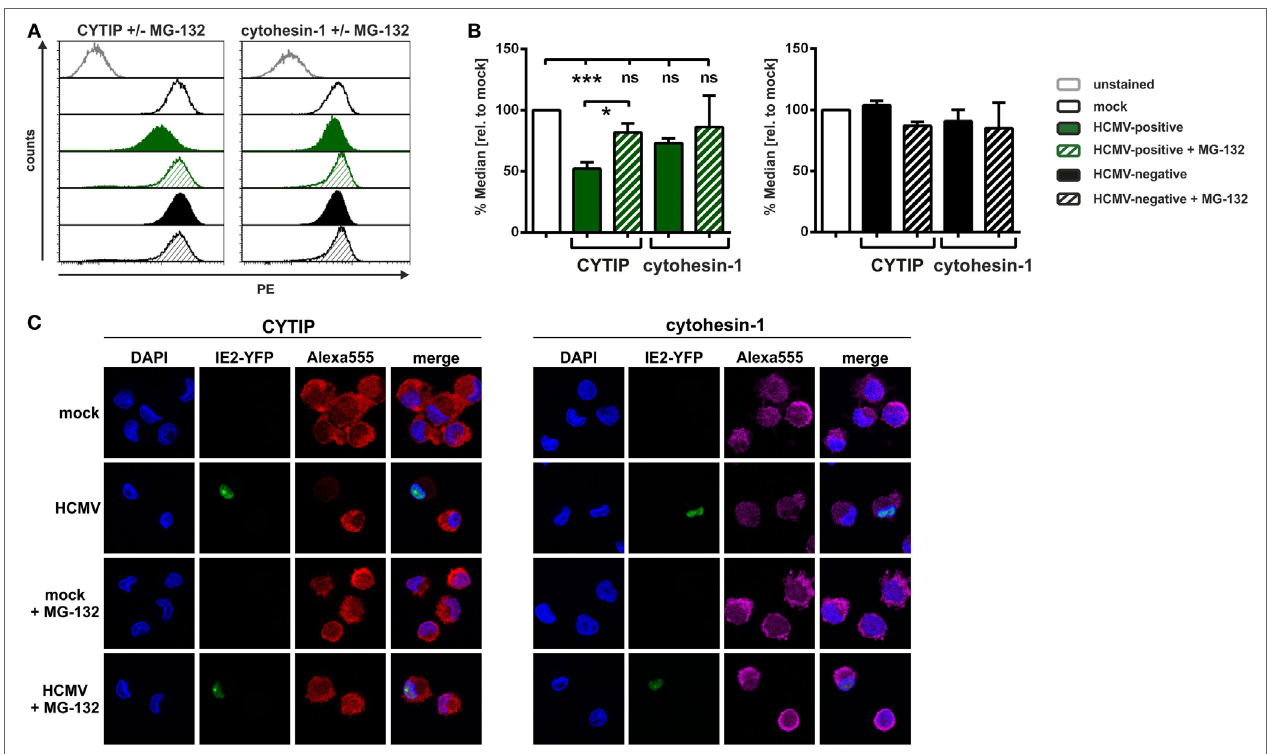
FigUre 6 | in human cytomegalovirus (hcMV)-infected mature Dcs (mDcs) cYTiP is degraded via the proteasome . Mature dendritic cells were mock- or HCMV-infected, treated with or without MG-132 and harvested 24 hpi. (a,B) Subsequently, intracellular staining with antibodies specific for CYTIP or cytohesin-1 was performed, and samples were subjected to flow cytometric analyses. (a) One representative experiment is shown for CYTIP (left panel) or cytohesin-1 (right panel) levels. Mock conditions (black lined histograms), HCMV-positive cells (green filled histograms), and HCMV-negative cells (black filled histograms) are shown, while the respective MG-132-treated samples are depicted as striped histograms. (B) Summarized data of at least three independent experiments of CYTIP and cytohesin-1 protein levels, analyzed via intracellular flow cytometry. Median values of HCMV-positive mDCs with and without MG-132 treatment (green filled and green striped bars, respectively; left panel) as well as HCMV-negative mDCs with and without MG-132 treatment (black filled and black striped, respectively; right panel) were calculated relative to the respective mock conditions with and without MG-132 (white bars, set to 100%). Significant changes (*** = p < 0.001; * = p < 0.05) are marked by asterisks, non-significant changes ( p > 0.05) as “ns.” (c) Immunofluorescence staining of CYTIP (left panel) and cytohesin-1 (right panel). The IE2-YFP fusion protein of the HCMV TB40E/IE2-EYFP strain allows direct determination of HCMV-positive and HCMV-negative cells. The nucleus was visualized using DAPI. The experiment was performed three times and representative data are